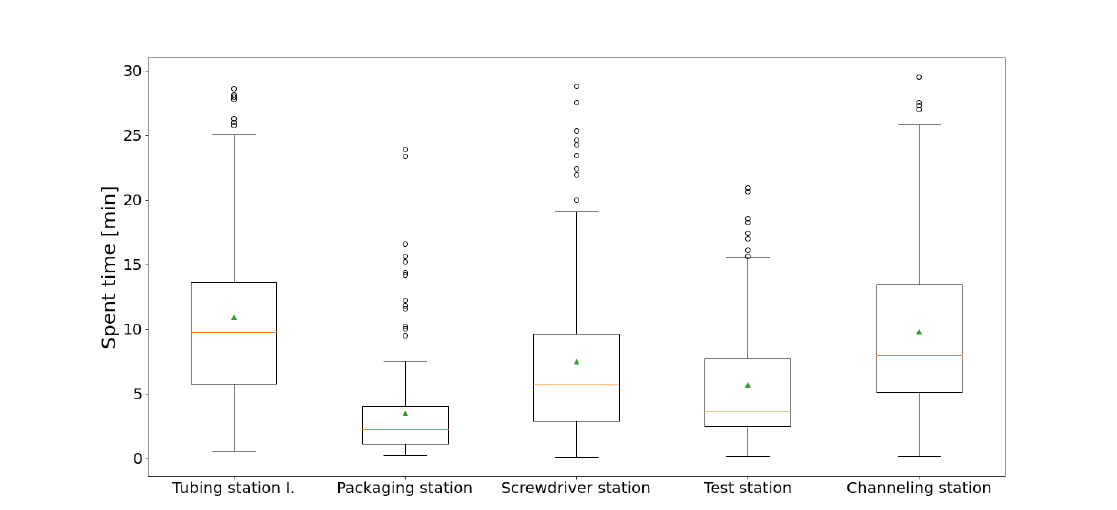
Figure 10. Boxplots of the cycle times measured at different zones of the production process. (Green triangles represent the averages, while red lines the